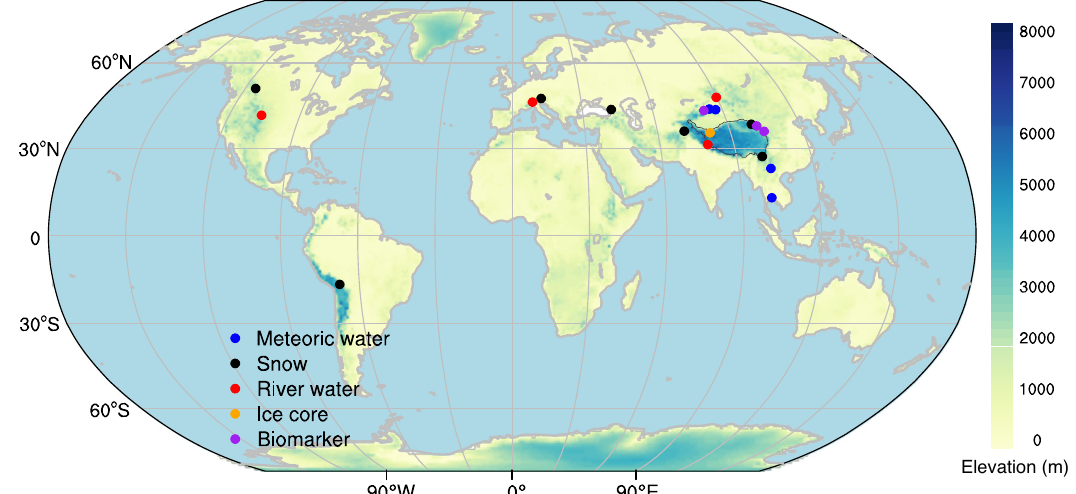
Fig. 1 | Geographic distribution of the IAE in stable isotopes reported in meteoric water, snow, river water, ice cores, and biomarkers. Detailed infor- mation on these sites is provided in Supplementary Table 1. IAE, inverse